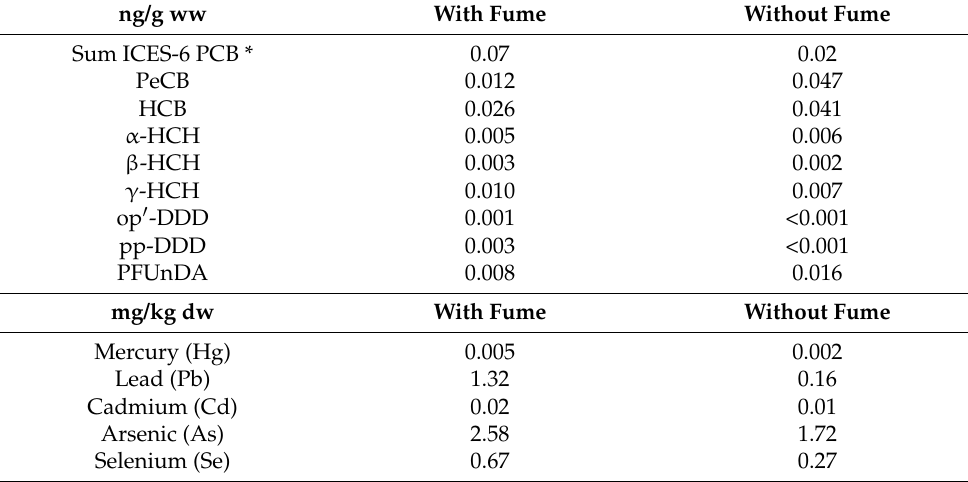
Table 11. Concentrations (ng g − 1 ww) of ICES-6 PCBs, various pesticides and metals (ng g − 1 dw) in the diatom fermented with and without fume (n = 2). Data for compounds with no detection in any samples are omitted from the table. ng/g ww With Fume Without